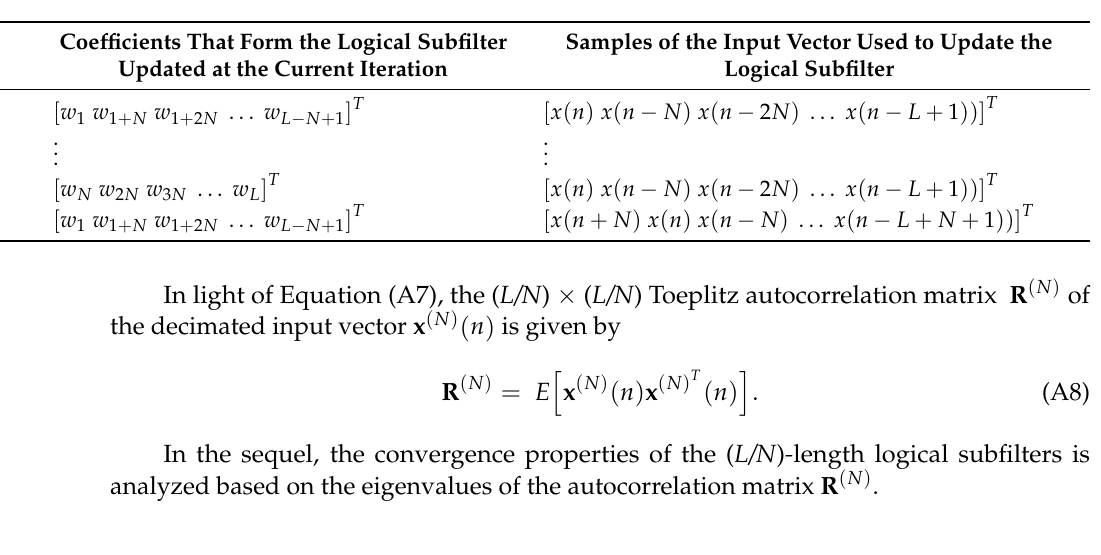
Table A1. Coefficients to be updated—defining a logical subfilter—during N + 1 consecutive iterations and their corresponding samples of the input vector.